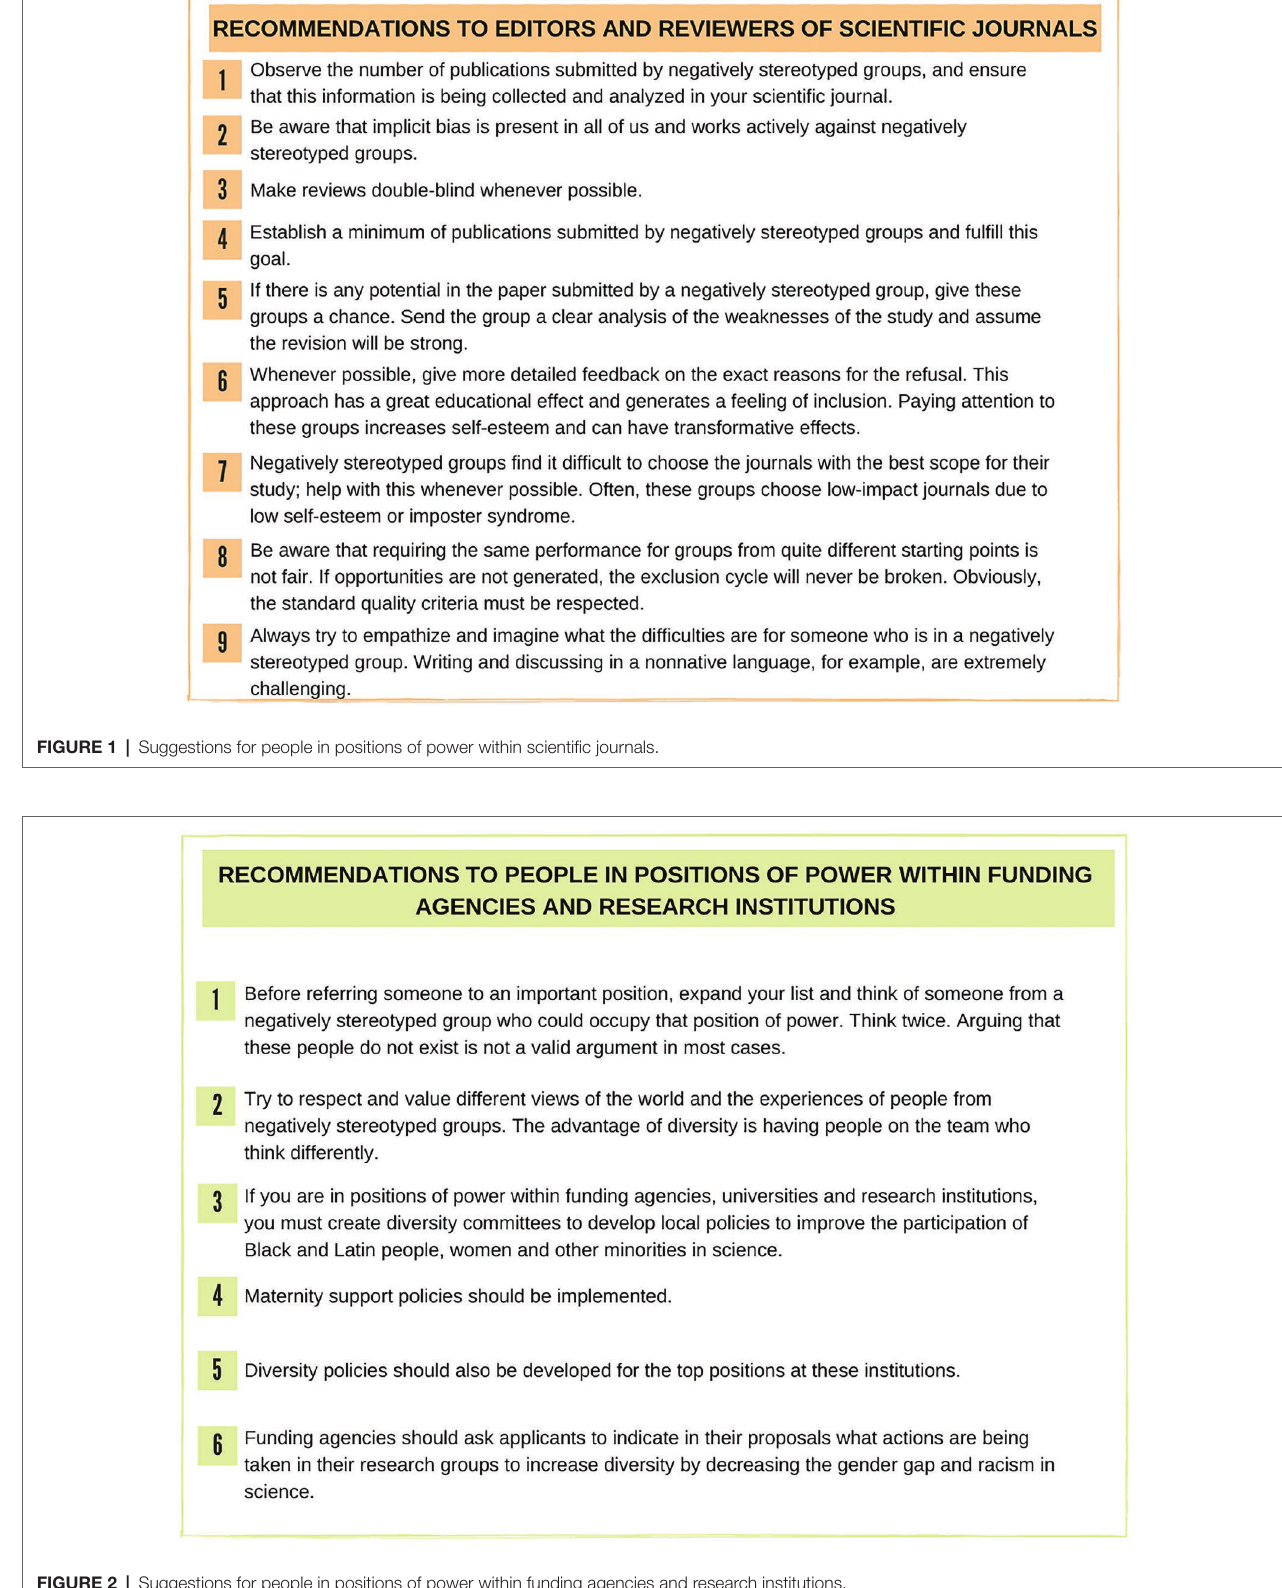
FIGURE 2 | Suggestions for people in positions of power within funding agencies and research